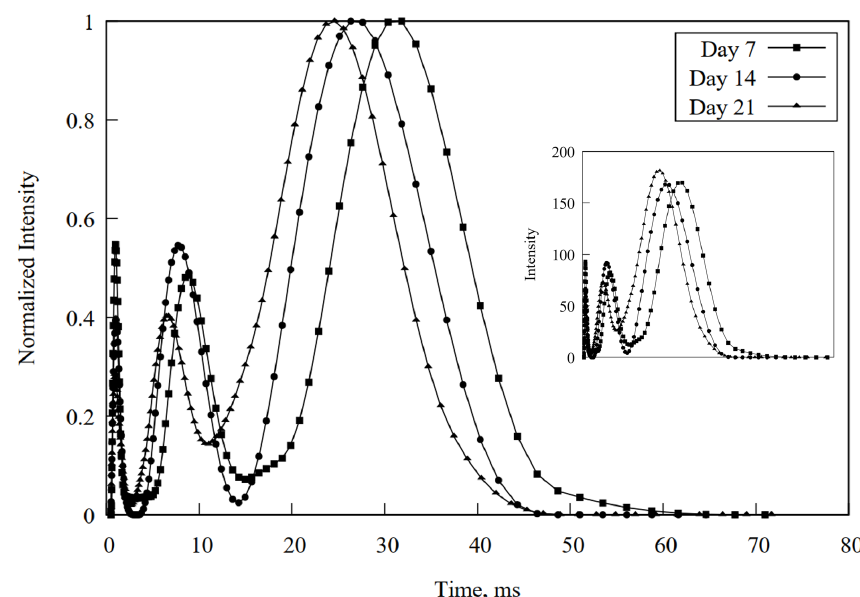
Figure 10. Relaxation time distribution (T 2 ) of Berea Sandstone saturated with crude oil for 21 days at 25 ◦ C.